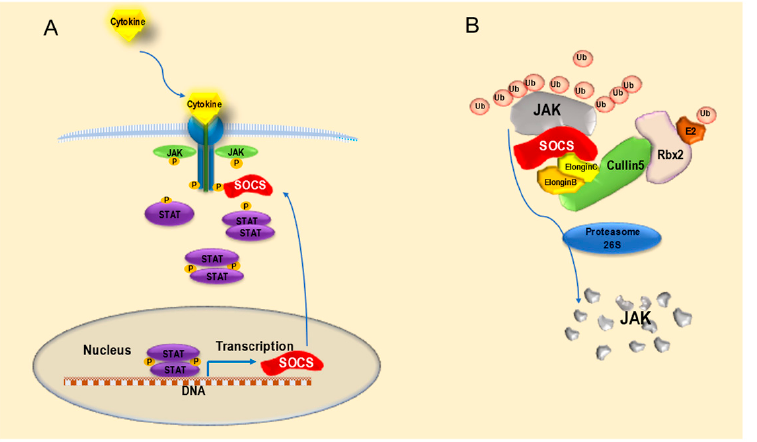
Figure 3. Molecular mechanism of the suppressor of cytokine signaling (SOCS) proteins. ( A ) After cytokines bind to its receptor, the Janus kinase–signal transduction and activator of transcription (JAK-STAT) pathway is activated, and the signal transduction and activator of transcription (STAT)- mediated expression of SOCS is induced. In turn, SOCS inhibits the JAK-STAT pathway in a negative feedback loop. ( B ) SOCS protein recruits Elongin C, Elongin B, Cullin5, Rbx2, and E2 and forms a SOCS/E3 complex. Thereafter, the SOCS/E3 complex binds Janus kinase (JAK); JAK is then ubiquitinated and finally degraded by proteasome 26S.